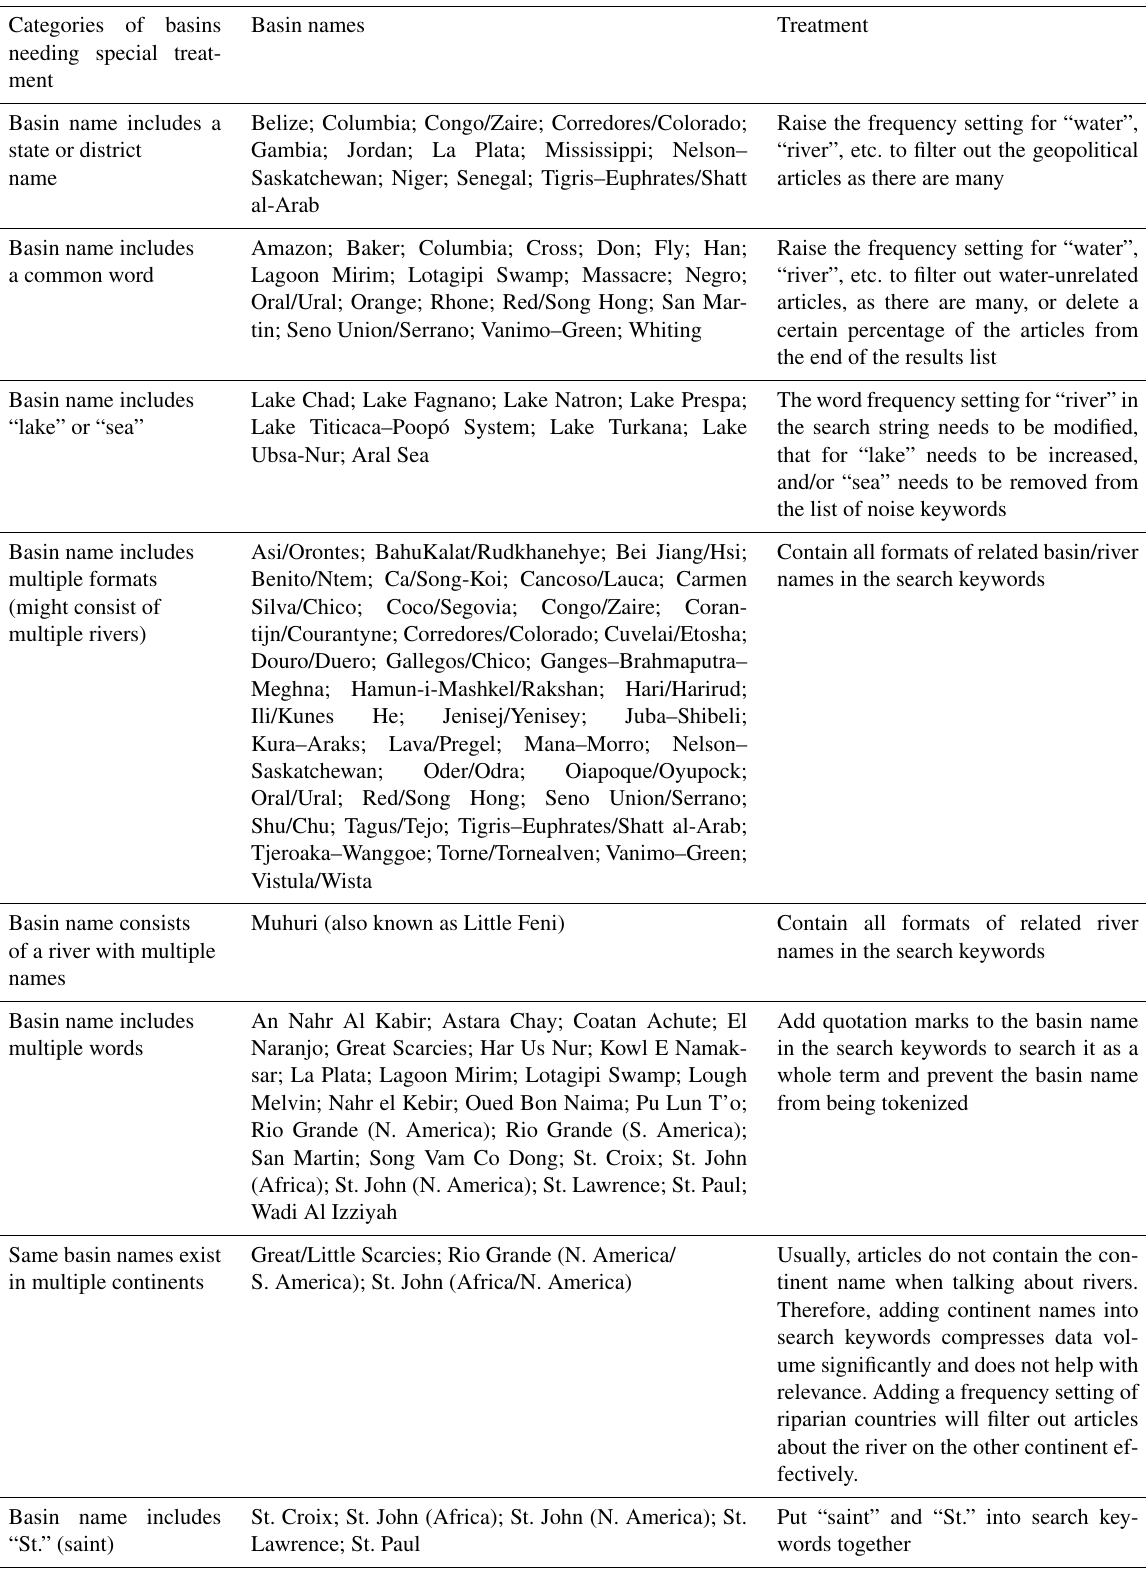
Table 1. Categories of basins needing special